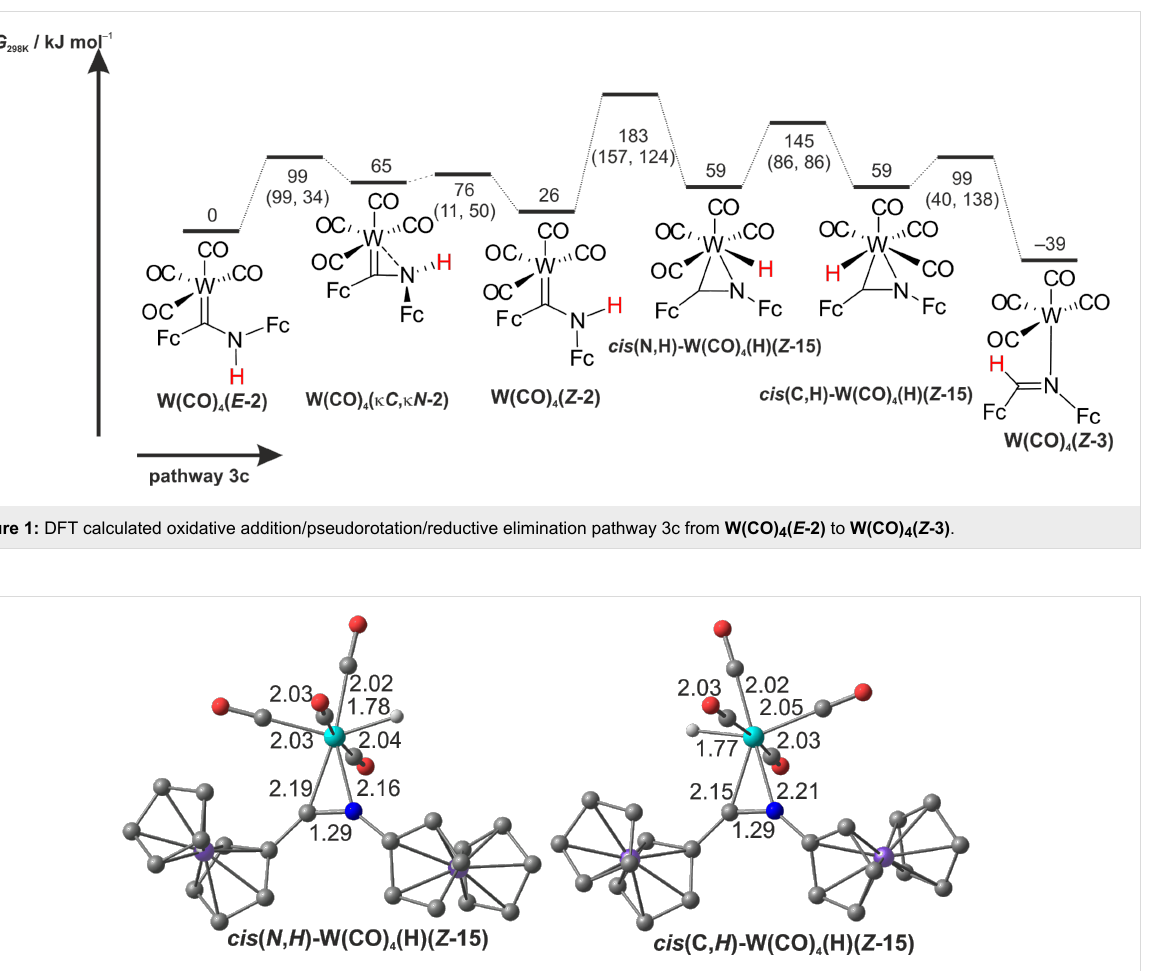
( Δ G ‡ = 40 kJ mol − 1 ) to give the imine complex W(CO) 4 ( Z -3) (Figure